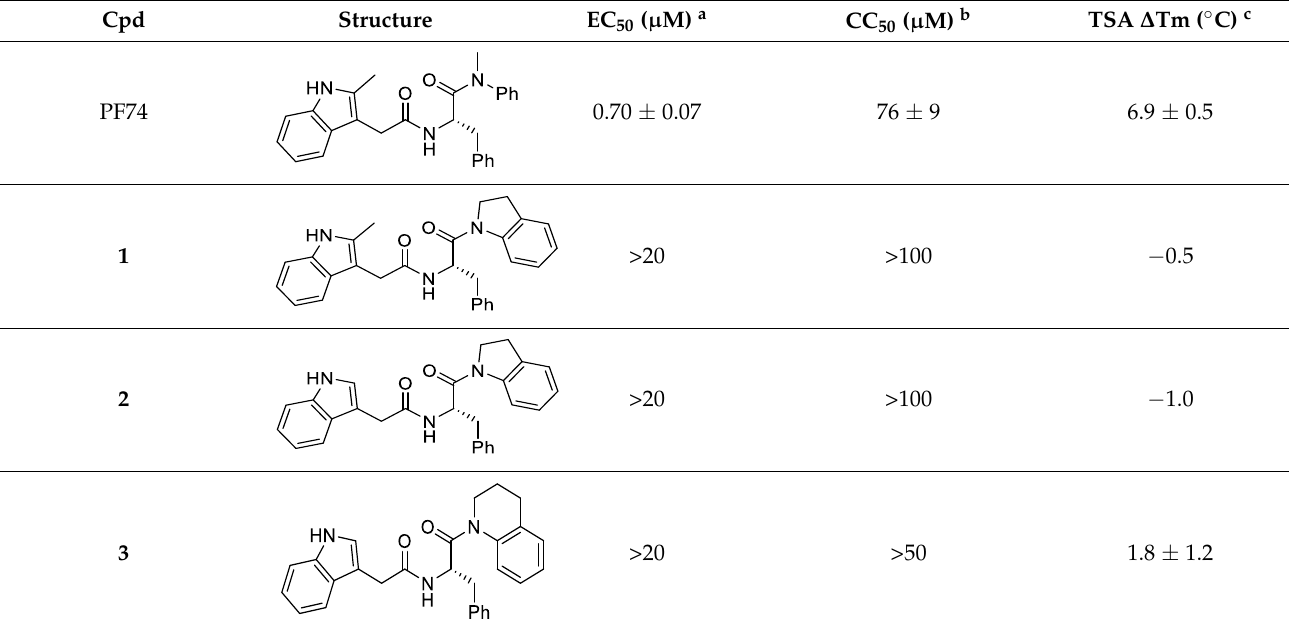
Table 1. Anti-HIV-1 activity, cytotoxicity, and CA hexamer stability profiles of chemotype 1. Cpd